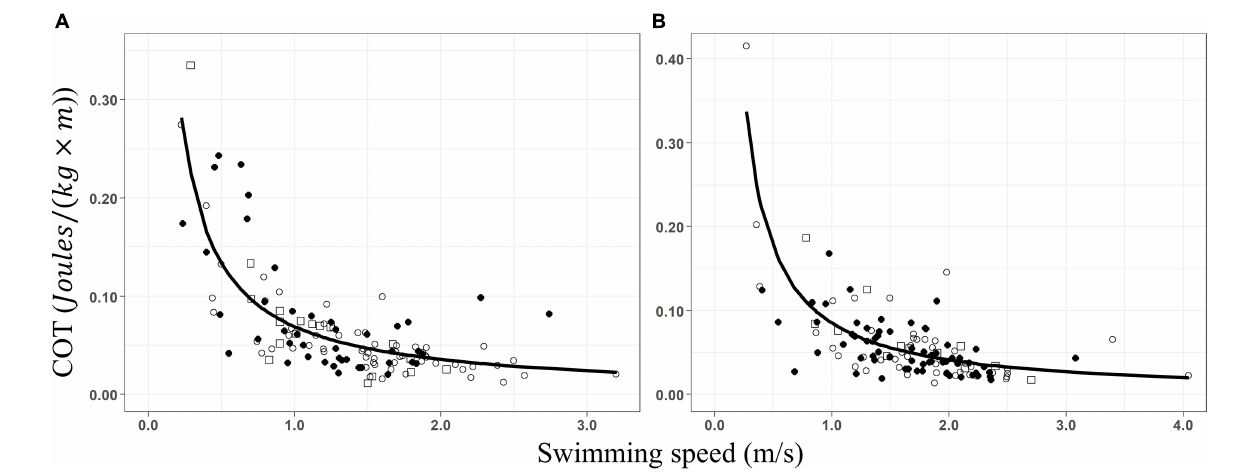
FIGURE 3 | Non-linear regressions of the mass-specific cost of transport (COT; J × [kg × m] - 1 ) as a function of the swimming speed (m/s) for (A) groups of whales with calves (COT = 0.069 × S - 0 . 95 , R 2 = 0.63) and (B) groups without calves (COT = 0.085 × S - 1 . 05 , R 2 = 0.53). Data from before ( (cid:13) ), during ( • ), and after ( (cid:3) ) the presence of the whale-watching